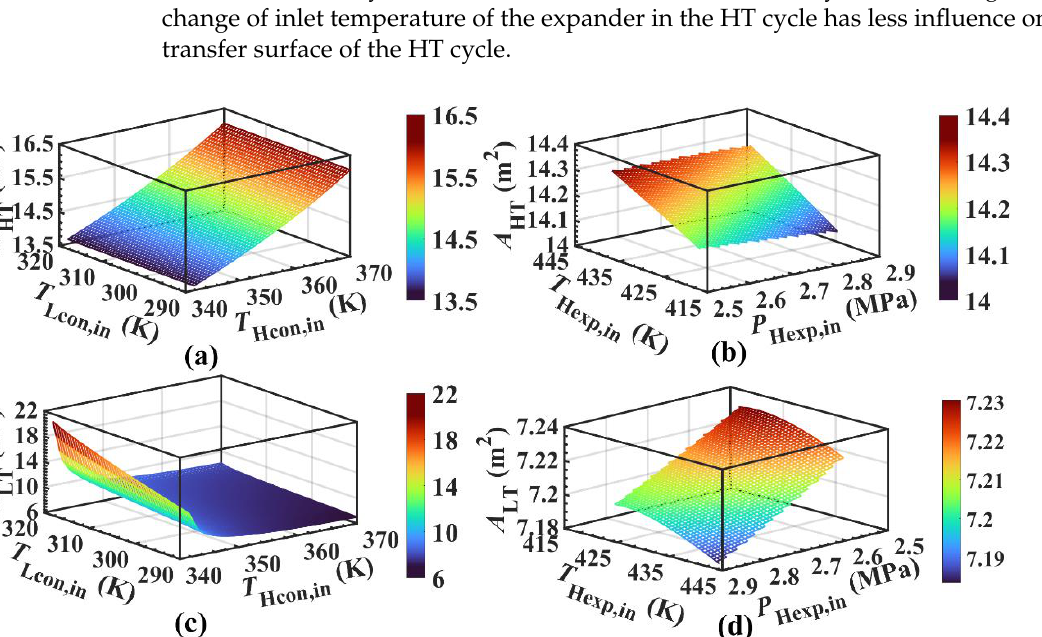
Figure 8. Heat transfer surface of HT cycle, LT cycle and system under variable working conditions. (a) Heat transfer surface for different loops. (b) System heat transfer surface.